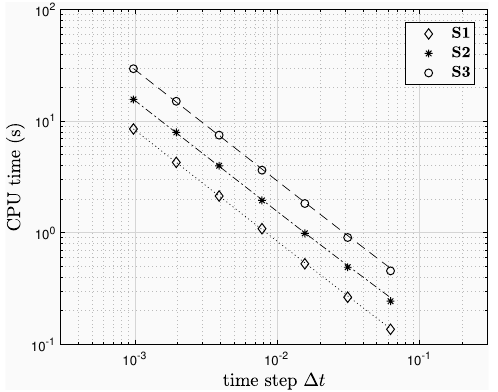
Figure 2. CPU time versus time step. Each line segment is obtained by least squares fitting of all corresponding